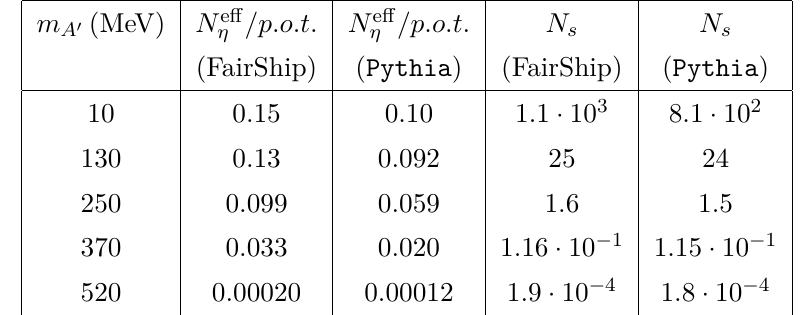
/p.o.t. is the effective number of η s per p.o.t. π 0 is the LDM yield for the s